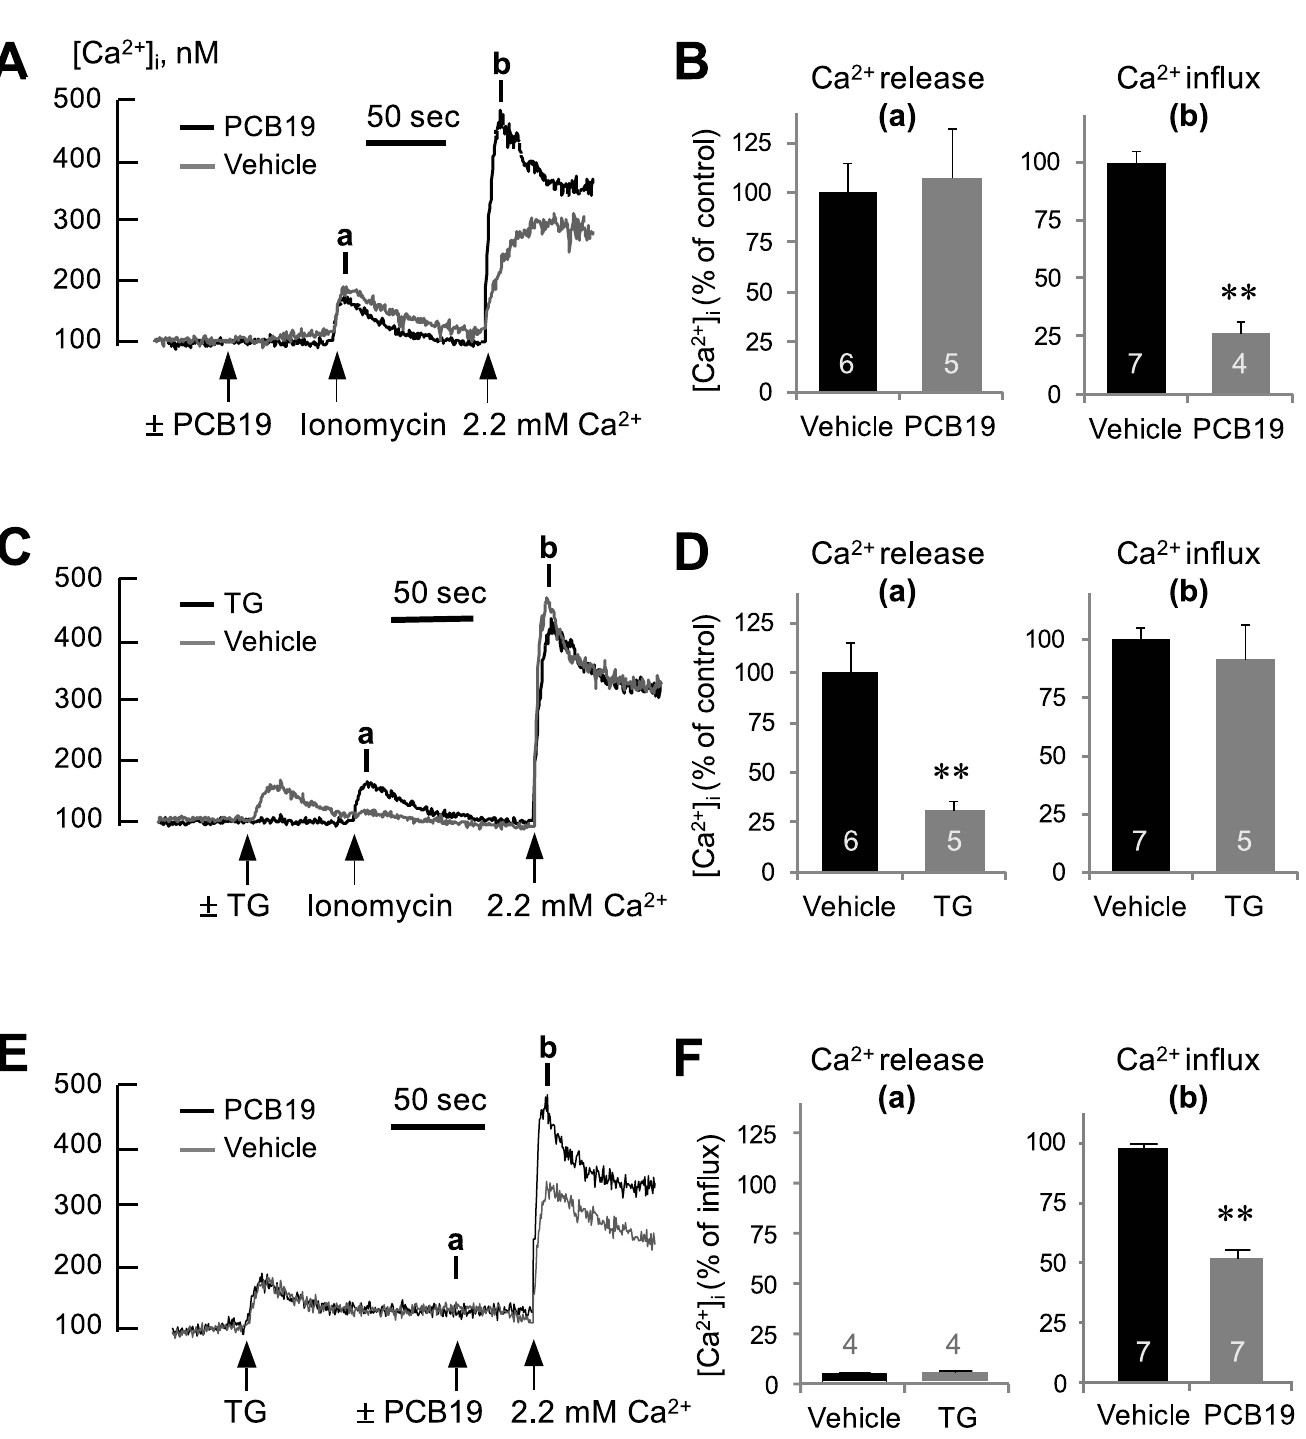
Fig 5. PCB19 inhibits ionomycin and thapsigargin-induced Ca 2+ influxes. (A, C, E) Fura-2-loaded PC12 cells were incubated in Ca 2+ -free Locke ’ s solution, challenged with 50 μ M PCB19, 1 μ M thapsigargin or 300 nM ionomycin, and treated with 2.2 mM CaCl 2 at the indicated time (arrow). (B, D, F) The [Ca 2+ ]i level at point a (Ca 2+ release) and b (Ca 2+ influx) were quantitatively analyzed using calcium traces and expressed as % of controls. Number of experiments are depicted in bar graph and each point represents mean ± SEM. TG, thapsigargin. ** P < 0.01.